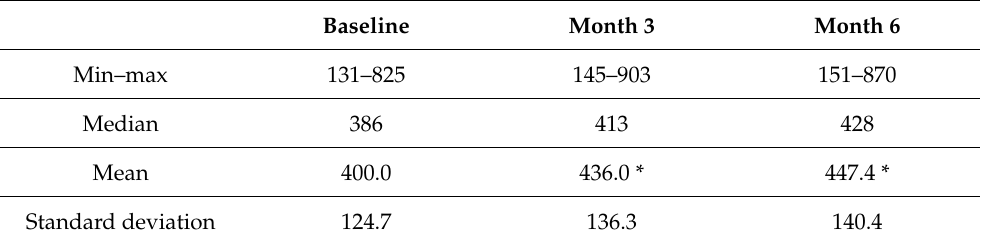
Table 5. Veggie Meter scores of 249 students at three measurement points.